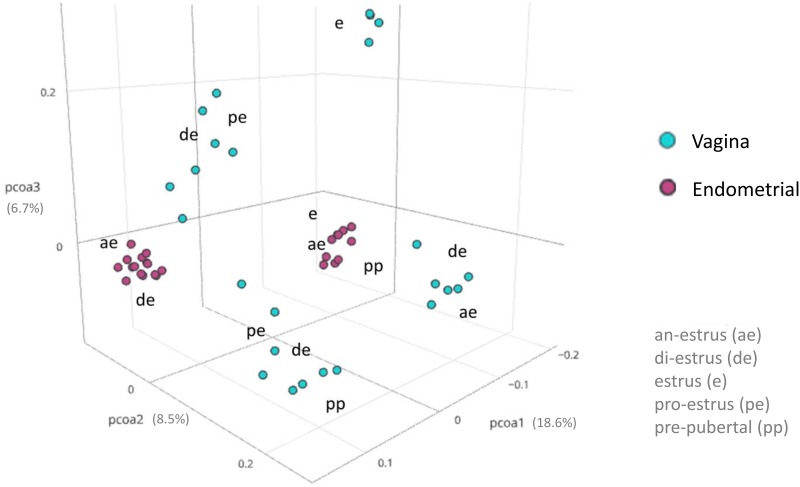
Principal Coordinates Analysis (PCoA).Distribution of bacterial communities based on the tissue and stage of estrous cycle. Community composition is measured using a UniFrac-weighted matrix. Vaginal samples are in blue and endometrial samples are in red. Anestrus-(ae), estrus-(e), diestrus-(de), pro-estrus-(pe) and pre-pubertal-(pp).